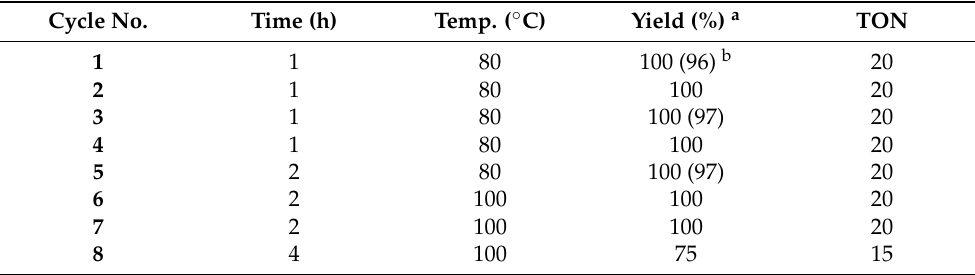
Table 6. Recycling results of A -catalyzed phospha-Michael addition of triethyl phosphite ( 2 ) 2- benzylidenemalononitrile ( 3 ). Cycle No.